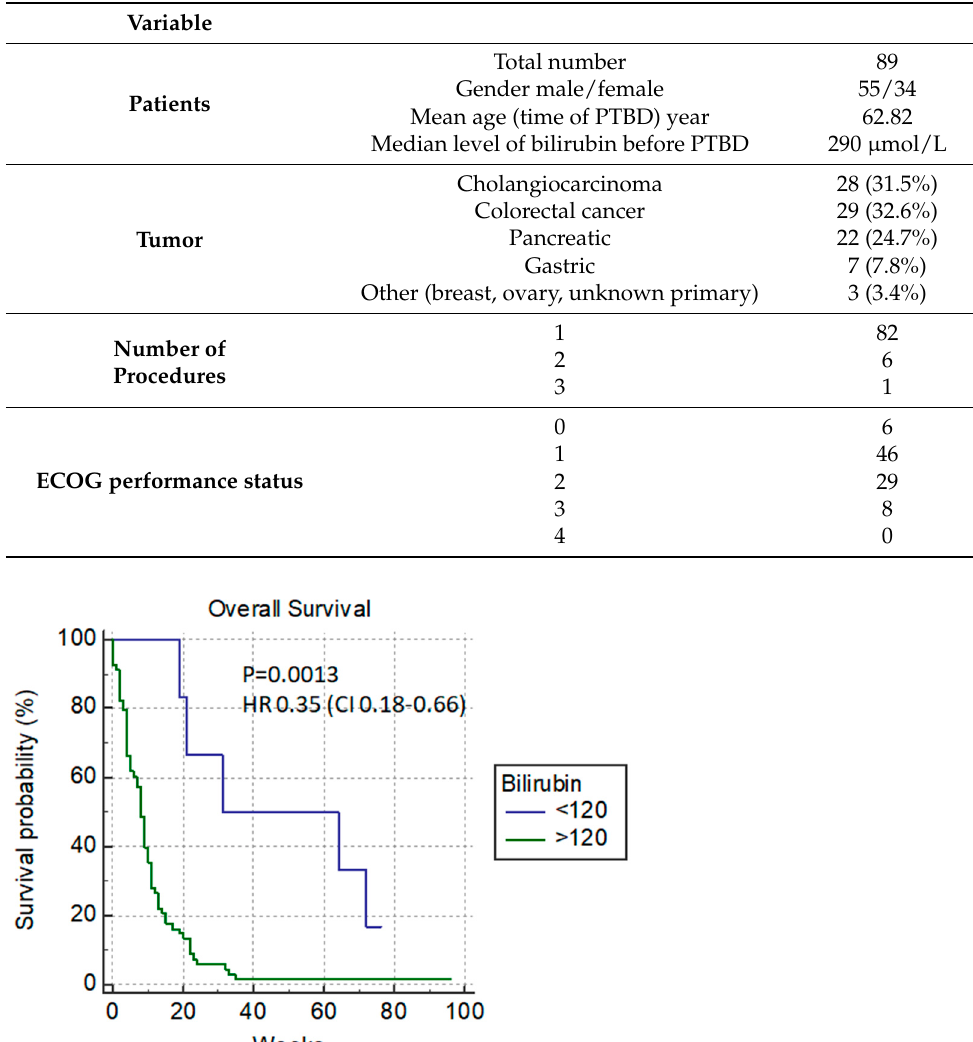
(31 vs. 8 weeks) p = 0.0013, HR 0.35 (0.18–0.66) (Figure 2).